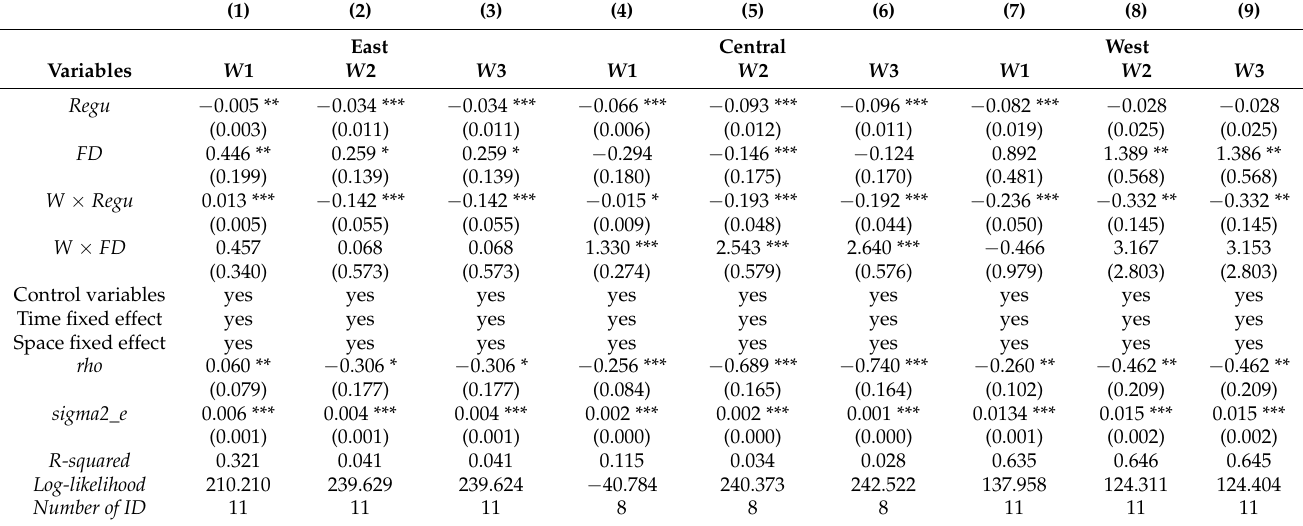
Table 13. Regression results of the impact of environmental regulation competition on carbon emissions by